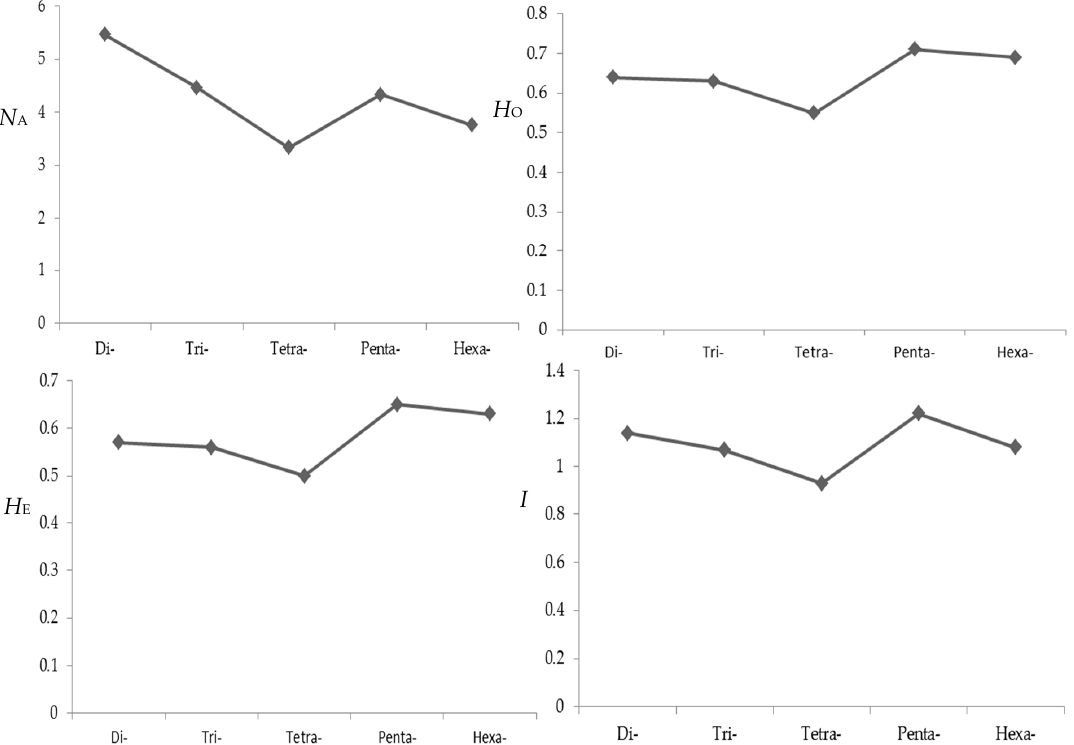
Figure 4. Influence of repeat type on polymorphism level of microsatellite markers. N A , number of alleles; H O , observed heterozygosity; H E , expected heterozygosity; I , Shannon-Wiener diversity index.